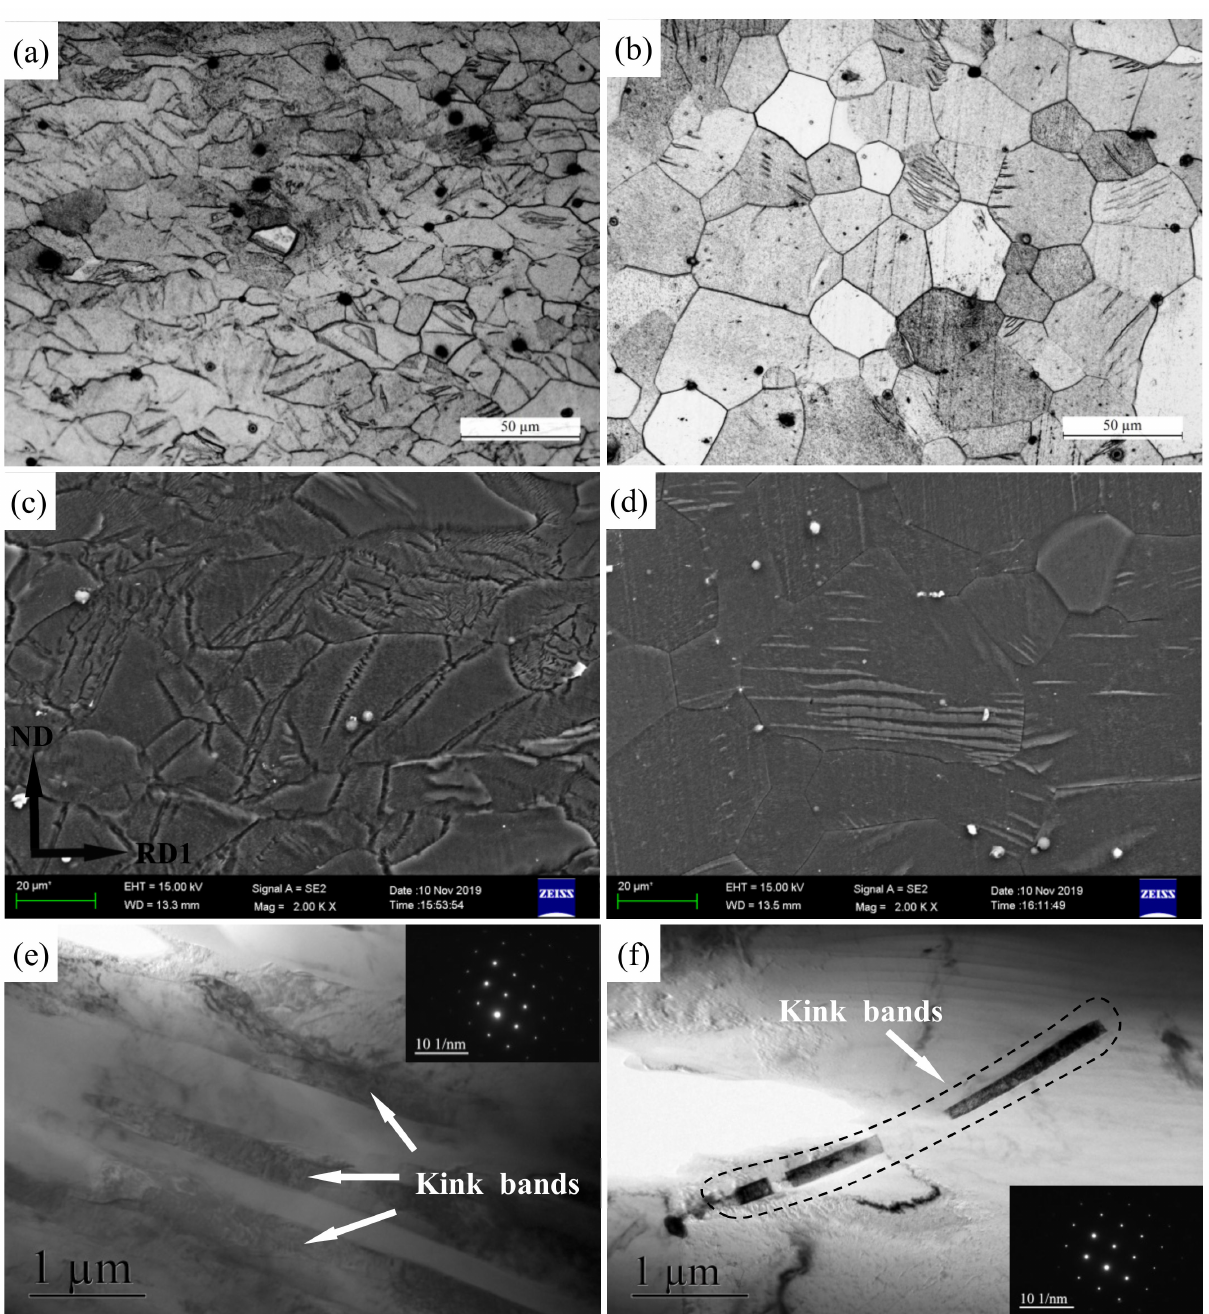
Figure 12. Optical micrographs of ( a ) as-rolled, ( b ) as-annealed, and corresponding SEM micrographs of ( c ) as-rolled and ( d ) as-annealed Mg-3Y sheets; TEM micrographs of kink bands of ( e ) as-rolled and ( f ) as-annealed Mg-3Y